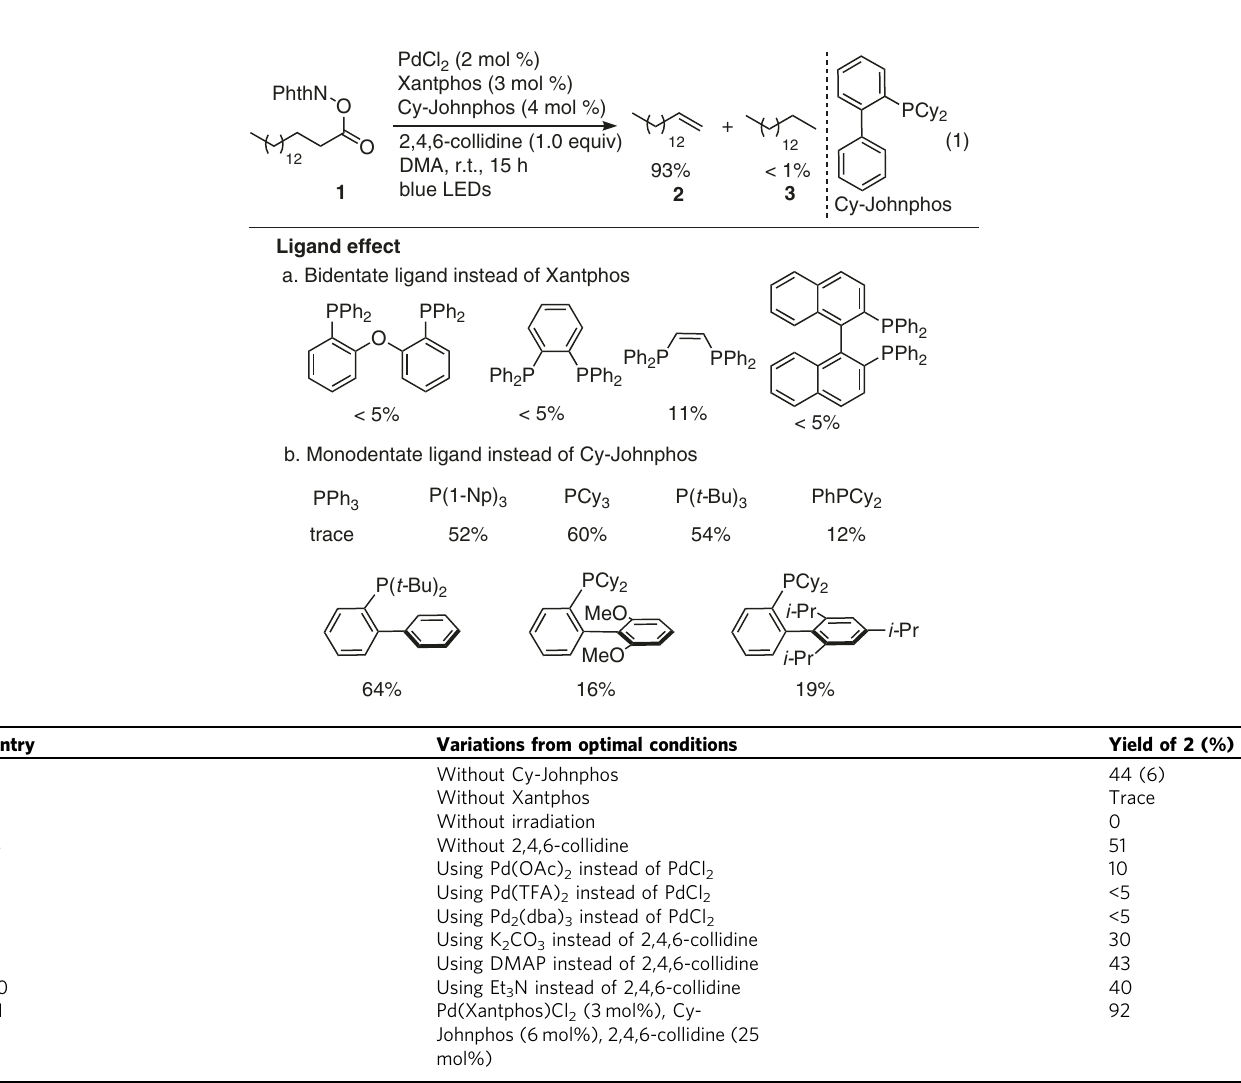
Table 1 Parameters affecting the reaction and the effects of the ligand